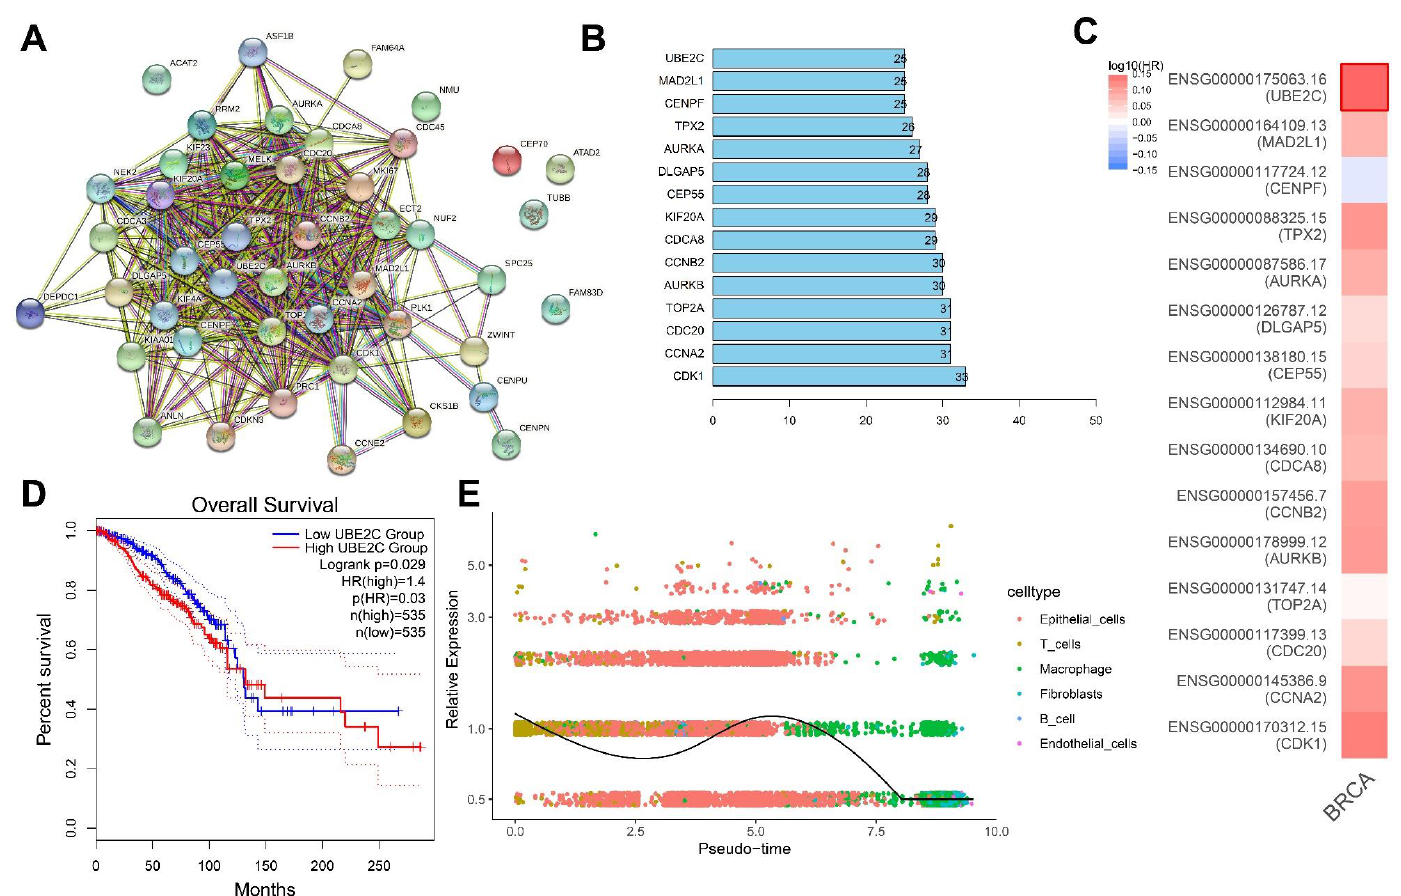
Figure 5. Screening of the core downstream genes of ALKBH5. ( A ): A PPI network of proteins encoded by the 45 key genes constructed using the STRING database. Each dot represents the protein encoded by the key gene and the connecting line indicates the existence of PPI; ( B ): The top 15 core genes determined based on the Degree values. The abscissa is the Degree value, namely the number of connected genes; ( C ): GEPIA2 analysis of the correlation of 15 core genes with the survival of TNBC patients. Red indicates the high-risk genes, blue indicates the low-risk genes, darker color indicates higher correlation, and bold border indicates p < 0.05; ( D ): Survival curve of correlation of the UBE2C expression with the survival of TNBC patients (n = 1070); ( E ): Dynamic expression of UBE2C following trajectory analysis of the scRNA-seq data. Dots with different colors indicate different cell